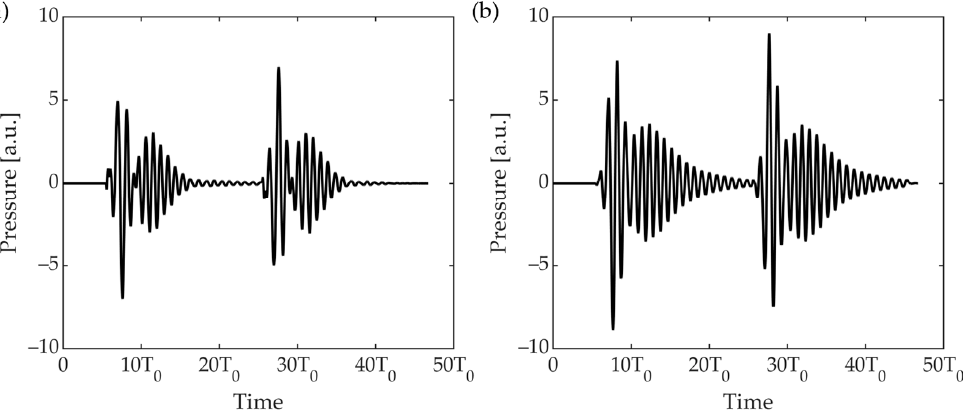
Figure 13. Meshed UUV model diagram. Effective mesh (red) and non-effective mesh (blue) according to angle of incidence and angle of reflection.